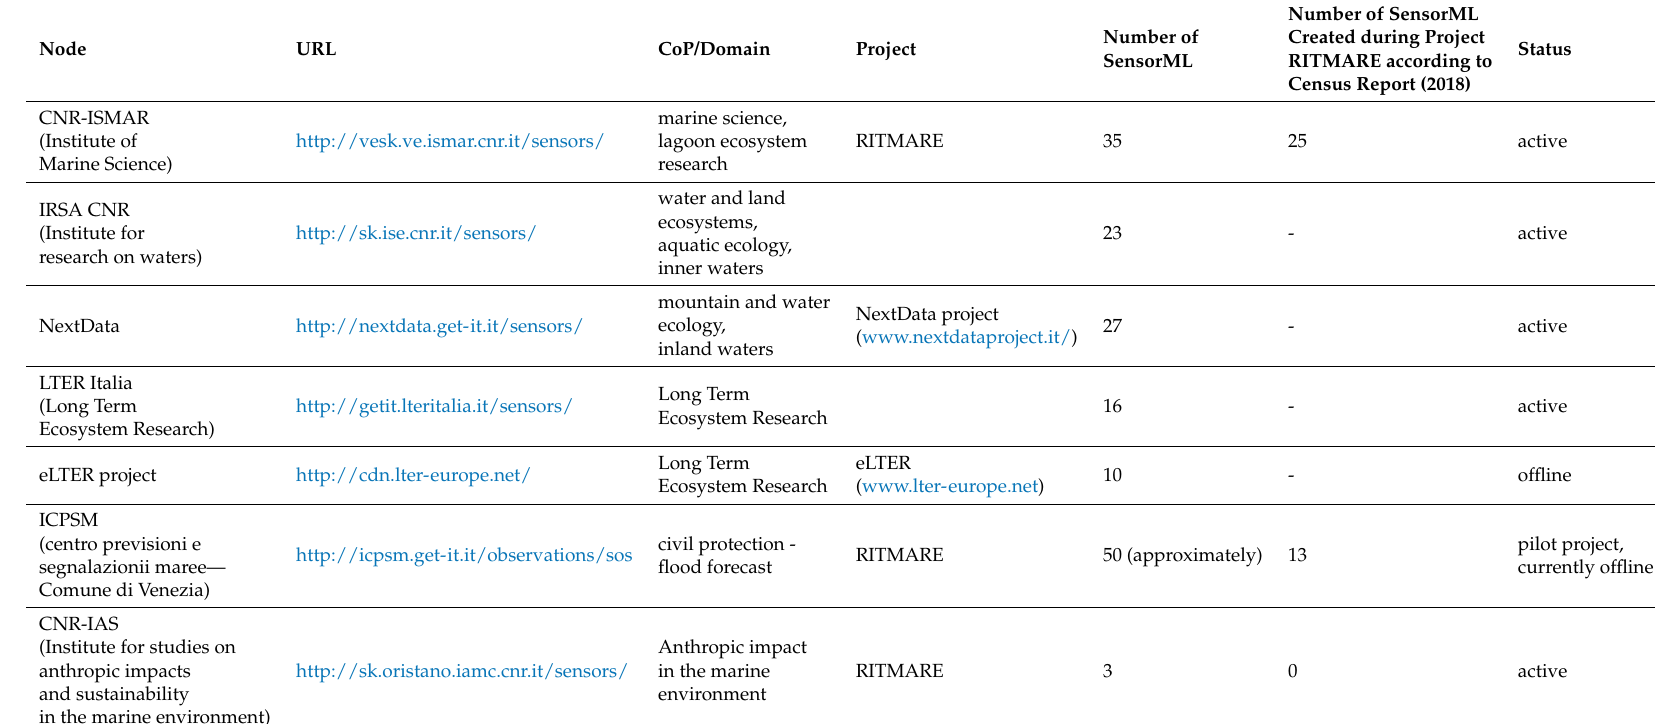
Table 2. Nodes enabled by the EDI